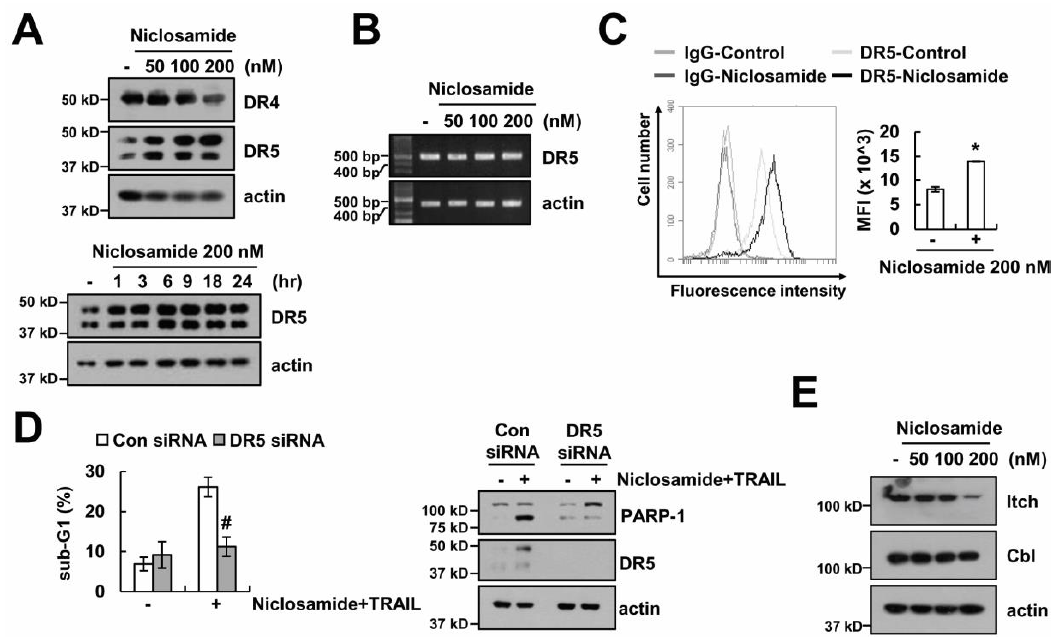
Figure 4. The up-regulation of DR5 by niclosamide is involved in TRAIL sensitization. ( A , B ) The protein and mRNA expression was determined by Western blotting ( A ) and RT-PCR ( B ) in Caki cells after treatment with niclosamide (50–200 nM) for 24 h. ( C ) The cell surface expression level of DR5 was measured by flow cytometry in Caki cells after treatment with 200 nM niclosamide for 24 h. ( D ) Apoptosis levels and protein expressions were determined by flow cytometry and Western blotting in Caki cells after transfection with control siRNA (Con siRNA) and DR5 siRNA, followed by treatment with 200 nM niclosamide plus 50 ng/mL TRAIL for 24 h. ( E ) The protein expression was determined by Western blotting in Caki cells after treatment with niclosamide (50–200 nM) for 24 h. The values in graph ( C , D ) represent the mean ± SEM of three independent samples. * p < 0.01 compared to the control. # p < 0.01 compared to the niclosamide plus TRAIL-treated control siRNA.